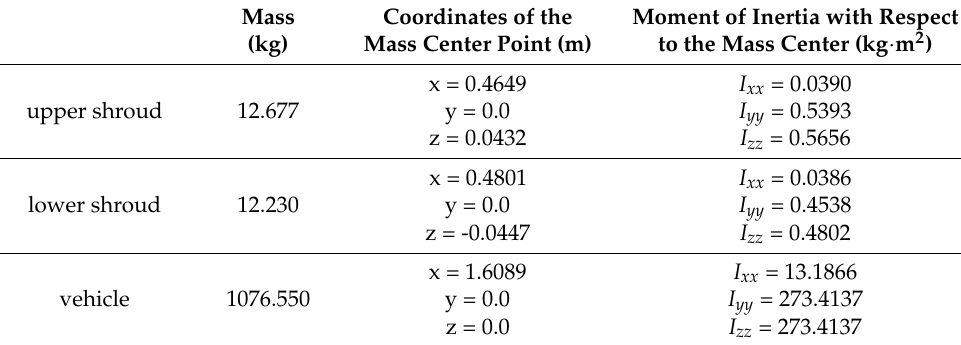
Table 3. Physical properties of the shrouds and vehicle.